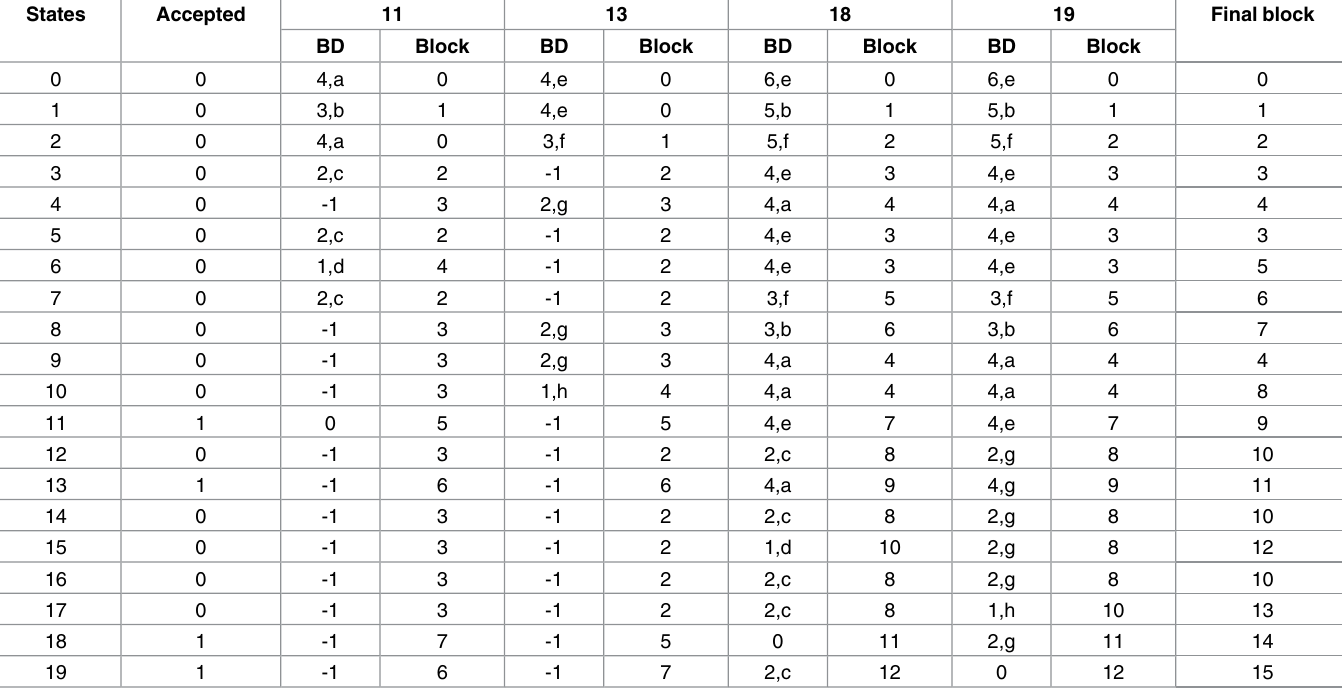
Table 2. Backwarddepth information for automata with the regular expressions (ab. * cd, ef. * gh).